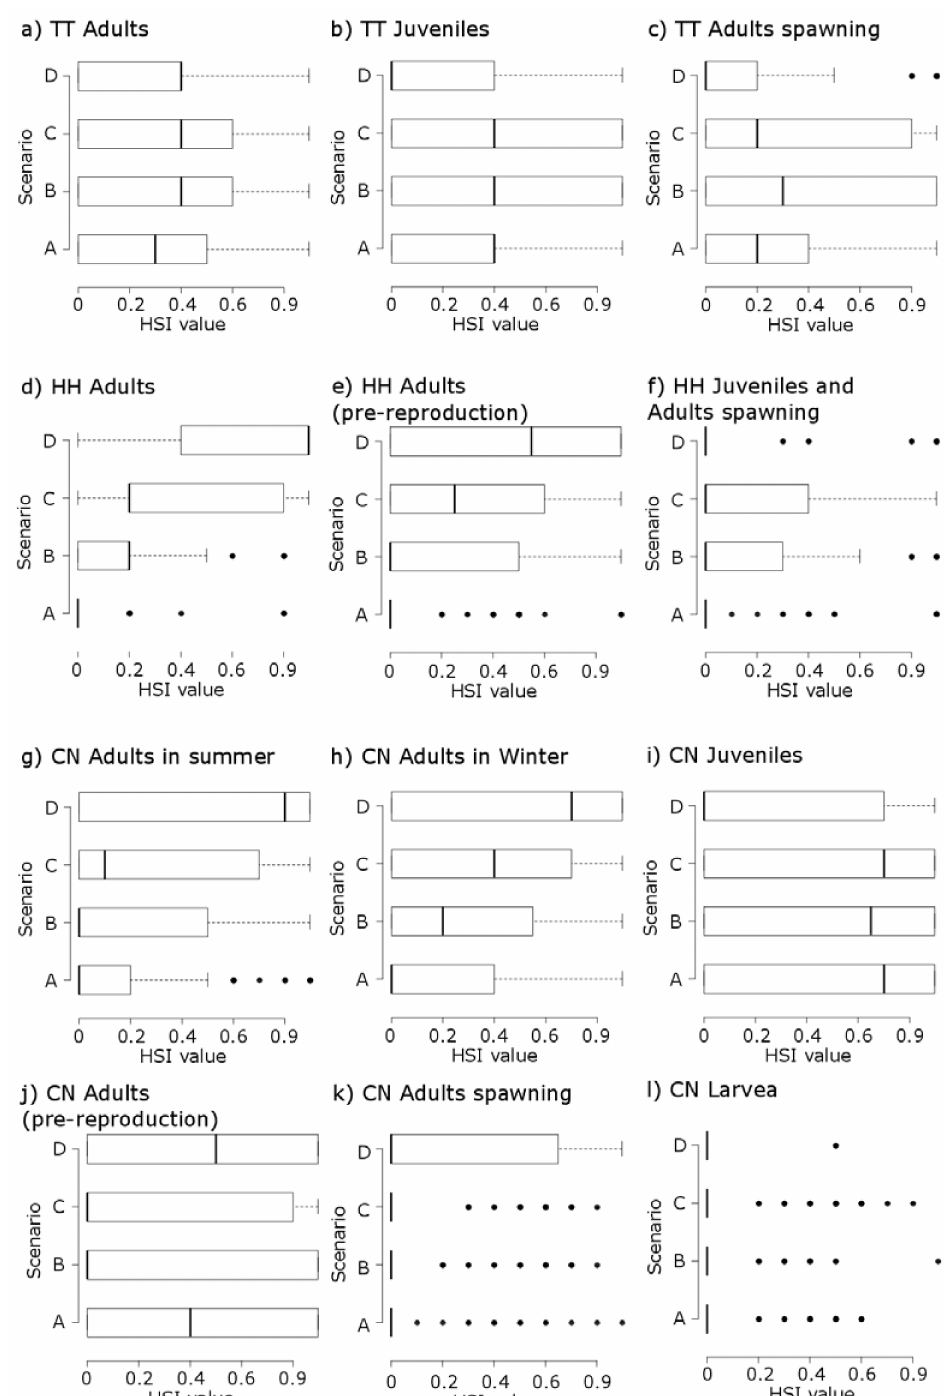
Figure 6. Box plots of the Habitat Suitability Index (HSI) value for the different scenarios considering each habitat type of Thymallus thymallus L. ( a – c ), Hucho hucho L. ( d – f ), and Chondostroma nasus L. ( g – l ). For abbreviations of habitat types see Table 1 (mean is the black line, black dots are